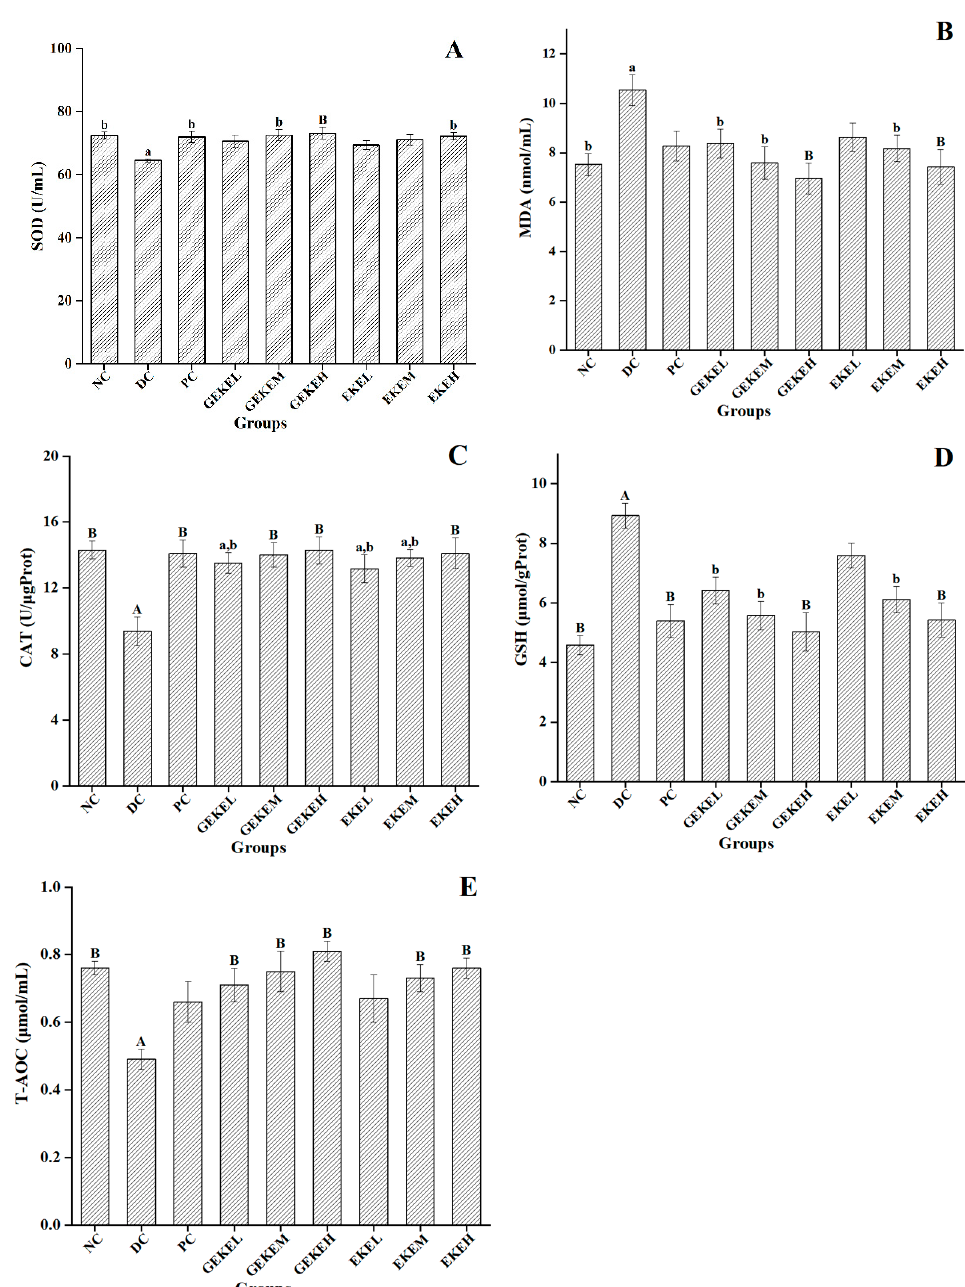
Figure 3. Oxidative stress parameters in each group of mice. ( A ) SOD levels in kidney supernatant of mice in each group (n = 10 per group). ( B ) MDA levels in kidney supernatant of mice in each group (n = 10 per group). ( C ) CAT levels in kidney supernatant of mice in each group (n = 10 per group). ( D ) GSH levels in kidney supernatant of mice in each group (n = 10 per group). ( E ) T-AOC levels in serum of mice in each group (n = 10 per group). A ( p < 0.01) and a ( p < 0.05) indicate comparison to the normal control; B ( p < 0.01) and b ( p < 0.05) indicate comparison to the diabetes